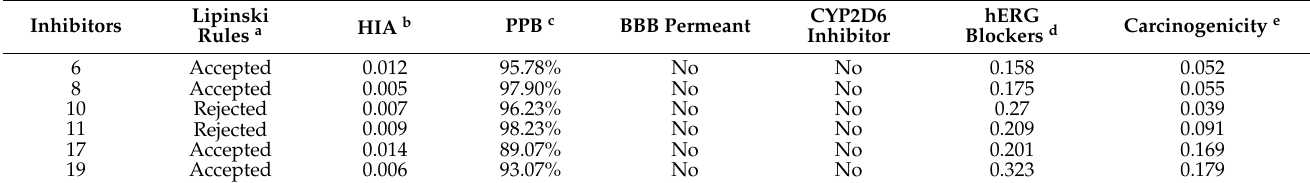
Table 2. The prediction of ADMET with 1,7-dihydro-dipyrrolo [2,3-b:3 (cid:48) ,2 (cid:48) -e] pyridine as the core